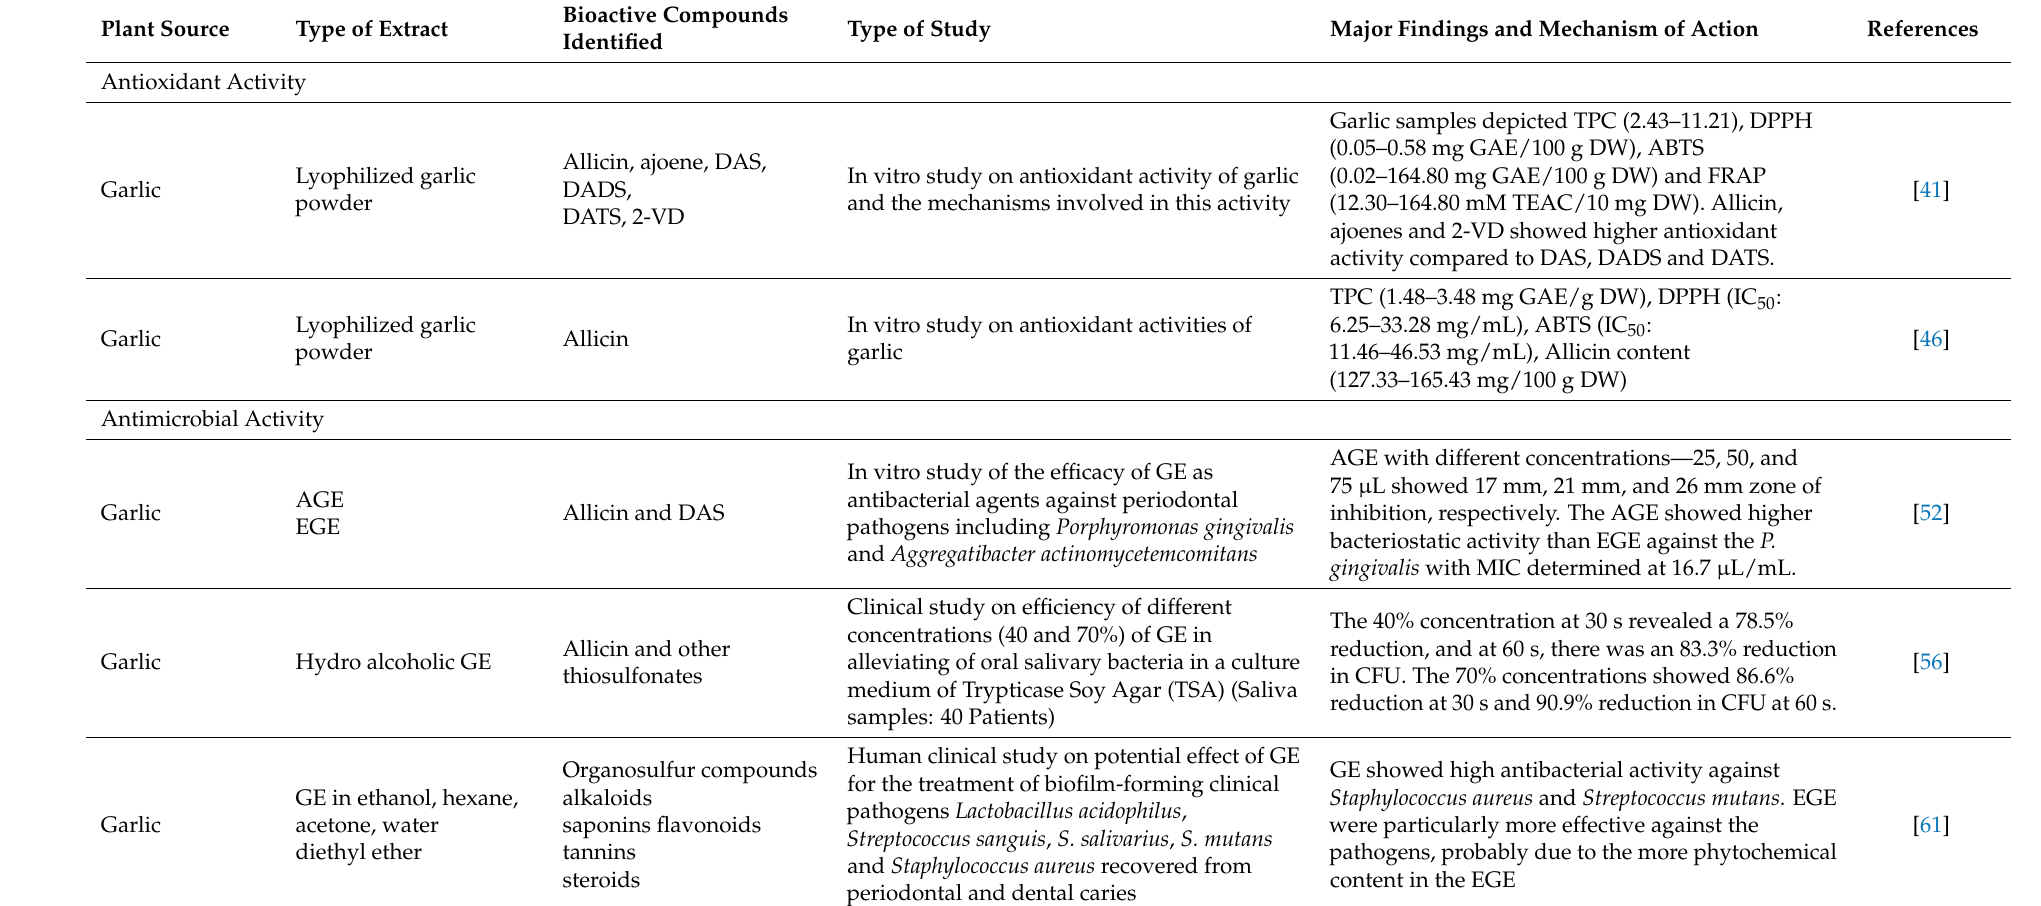
Table 2. Biological activities of garlic in management of oral